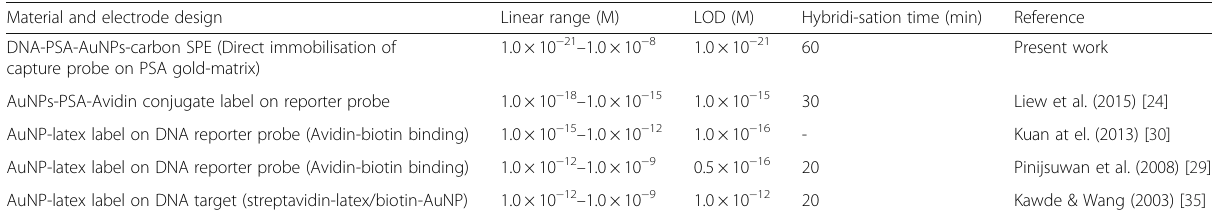
Table 5 A comparison of the developed DNA biosensor performance with other previously reported electrochemical DNA biosensor for the determination of pathogenic V. cholere DNA Material and electrode